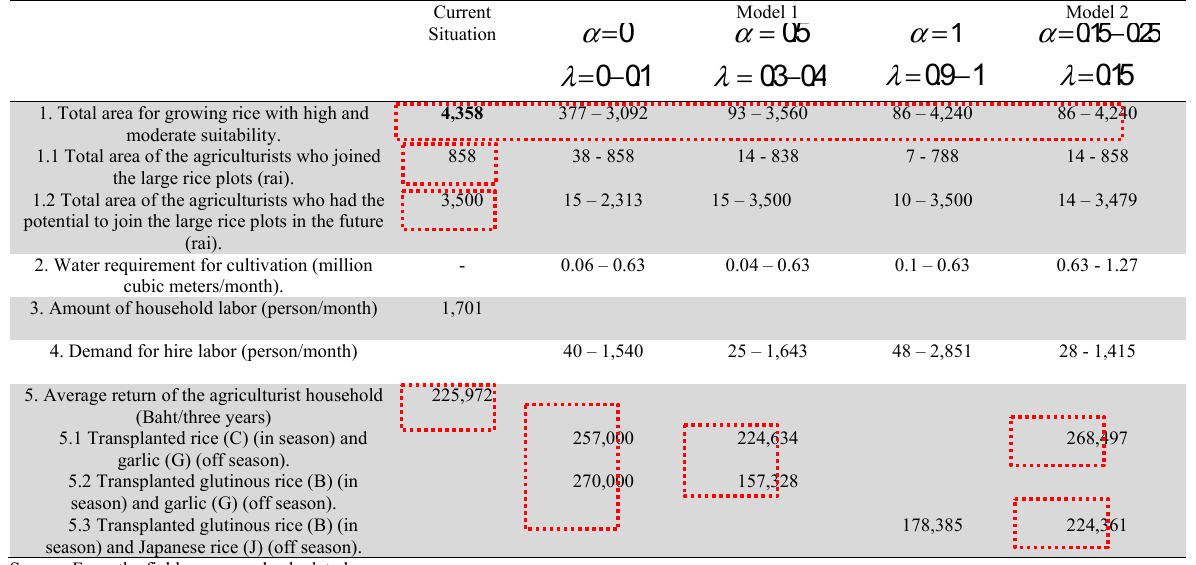
The use of the inputs, resources, and return from the model compared with the current